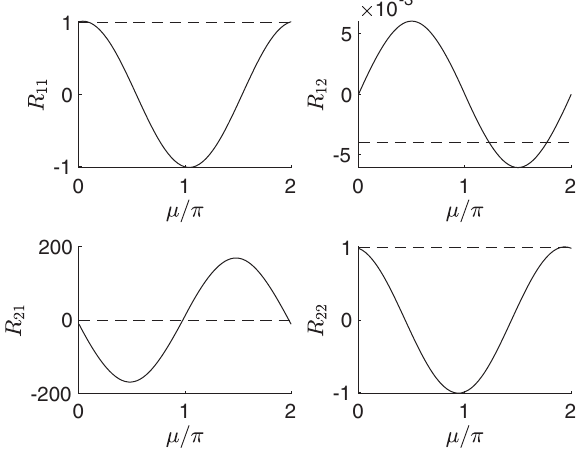
FIG. 10. Elements of nonperiodic transfer matrix over a range of phase advances for a beam with an rms radius of 24 μ m and an rms angle of 4 mrad focused at the entrance of DLW 1 . Horizontal dashed lines indicate the values predicted by the pseudoinverse